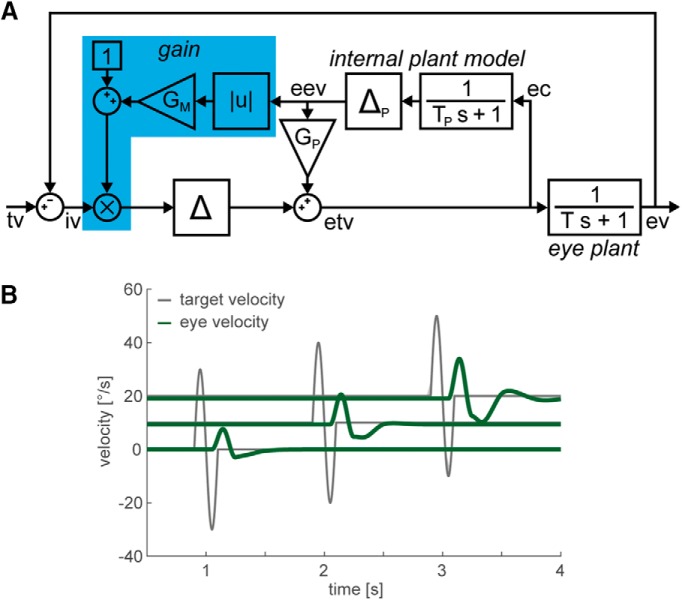
A, Smooth pursuit control circuit adapted from the study by Nuding et al. (2008). The model is based on the standard “internal feedback” model by Robinson et al. (1986), extended by a basic gain control mechanism (blue). Hereby, the retinal image velocity signal is modulated by an internal estimate of gaze velocity (Carey and Lisberger, 2004; Bayer et al., 2008; Lee et al., 2013). The retinal image velocity (iv) is the difference between target velocity (tv) and eye velocity (ev). The eye plant was modeled by a first-order low pass with time constant T = 200 ms. An efference copy (ec) of the motor command is projected to an internal model of the eye plant (with a time constant TP = T), yielding an estimate of the eye velocity signal (eev). This signal is used to transform iv into an estimate of target velocity (etv). For a steady-state pursuit gain of ∼0.9, GP was set 0.9. The gain control mechanism increases pursuit gain for higher velocities by multiplying iv with the factor 1+GM · |eev|. The delay elements Δ and ΔP represent the processing latencies and were set to 150 ms. B, Perturbation responses increase with eye velocity. Single-cycle high-frequency perturbations were imposed on target velocity (gray) during fixation, as well as pursuit with constant velocities of 10 and 20°/s. Green traces show the model responses with GM = 0.05 for the three different conditions.